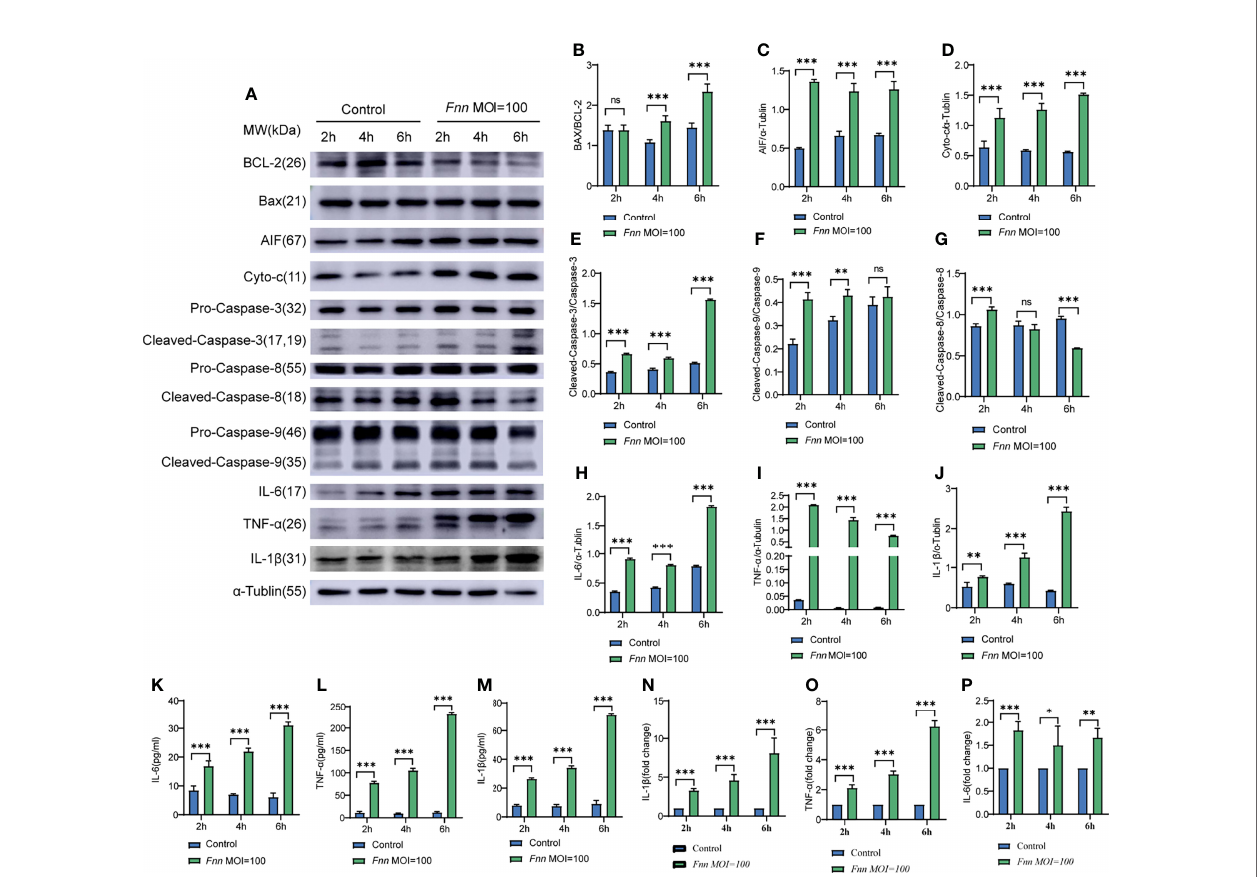
FIGURE 4 | The effect of F. necrophorum on apoptosis and in fl ammatory factors of macrophages was detected by Western blot and ELISA. (A) The protein levels of Bcl-2, Bax, AIF, cyto-c, pro-caspase-3, cleaved-caspase-3, pro-caspase-9, cleaved-caspase-9, IL-6, TNF- a and IL-1 b were detected by western blotting. The relative level of Bax/Bcl-2 (B) , AIF (C) , cyto-c (D) , cleaved-caspase-3/caspase-3 (E) , cleaved-caspase-9/caspase-9 (F) , cleaved-caspase-8/caspase-8 (G) , IL-6 (H) , TNF- a (I) and IL-1 b (J) was detected. ELISA detection of the levels of IL-6 (K) , TNF- a (L) and IL-1 b (M) in cells ( n = 3). The ratio of IL-1 b (N) , TNF- a (O) and IL-6 (P) between the Fnn MOI=100 group and the control group was detected by ELISA (n = 3). * P <0.05, ** P <0.01, *** P <0.001, ns, not signi fi cant.